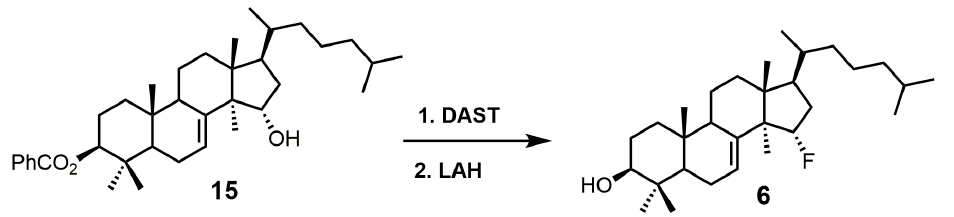
Figure 5. The synthesis of 15 α -fluoroIanost-7-en-3 β -ol ( 6 ).